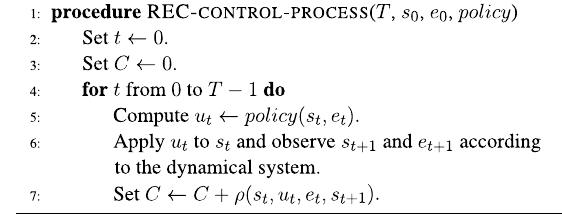
Algorithm 3 constructs this new policy with a full definition